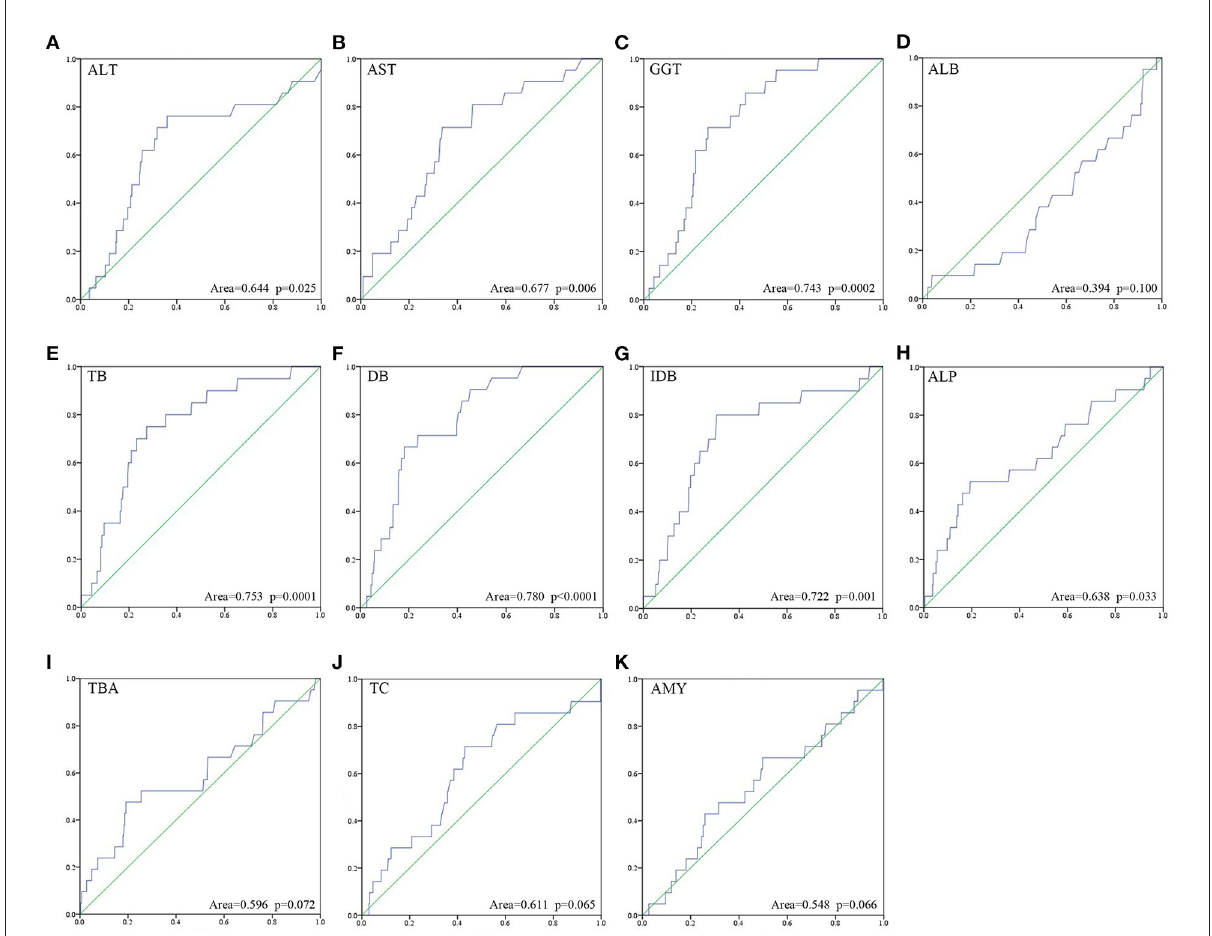
FIGURE1 Univariate ROC curve analysis about risk of perforation onto each of the eleven serum biochemical indices (A–K) was